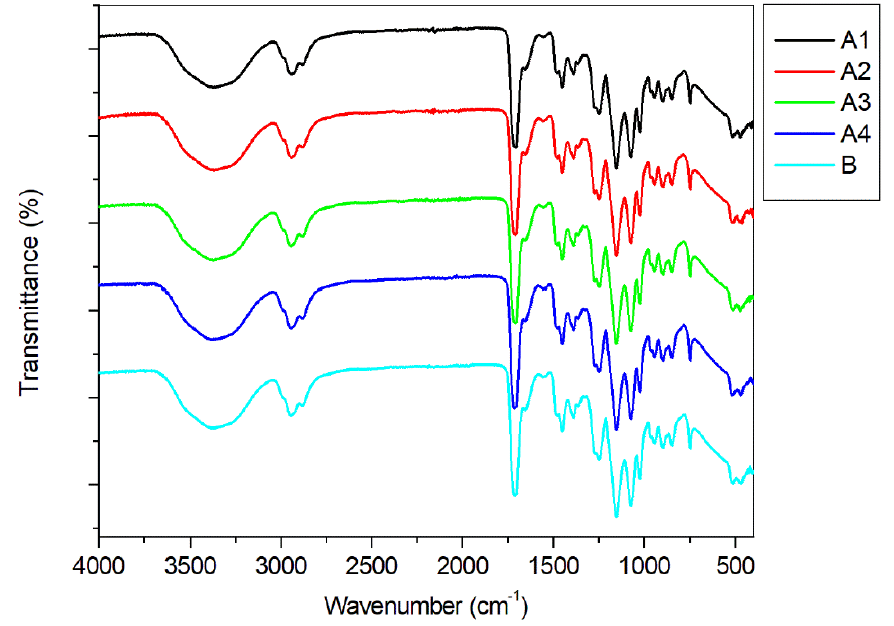
Figure 4. ATR-FTIR analysis of films A1 – A4 , B .